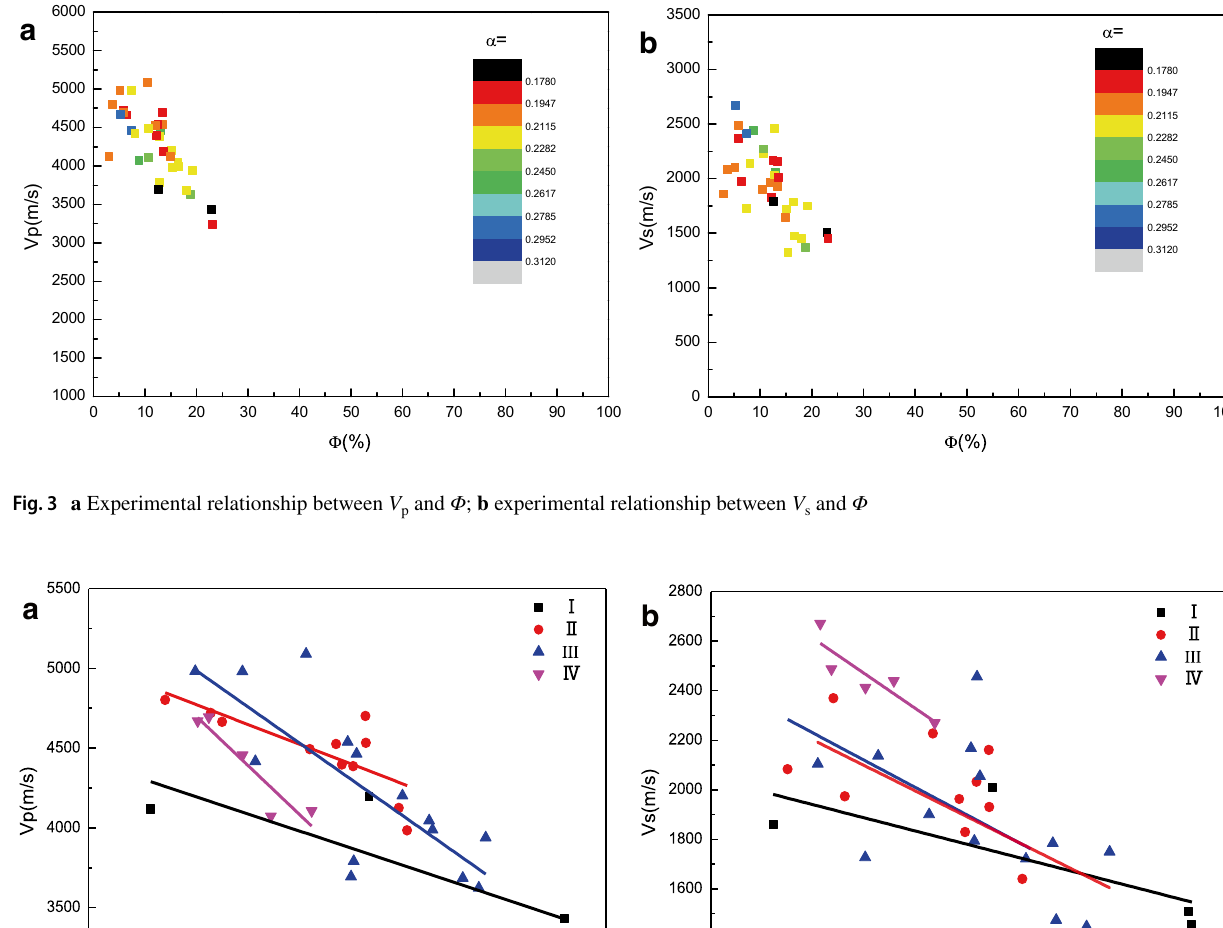
Φ in different pore structure s and